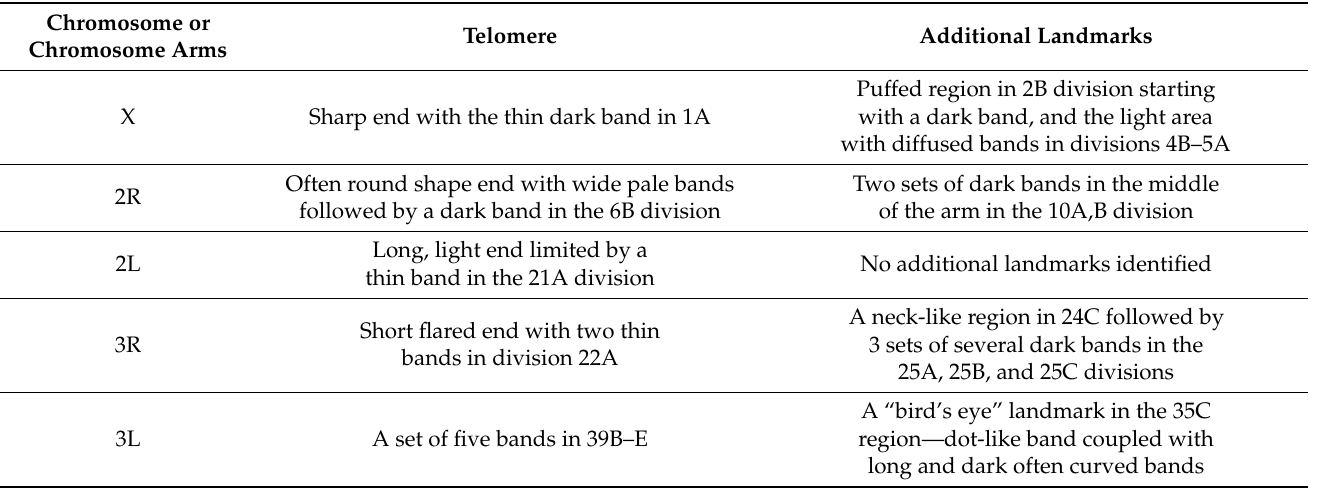
Table 2. Important chromosome landmarks for arm and inversion